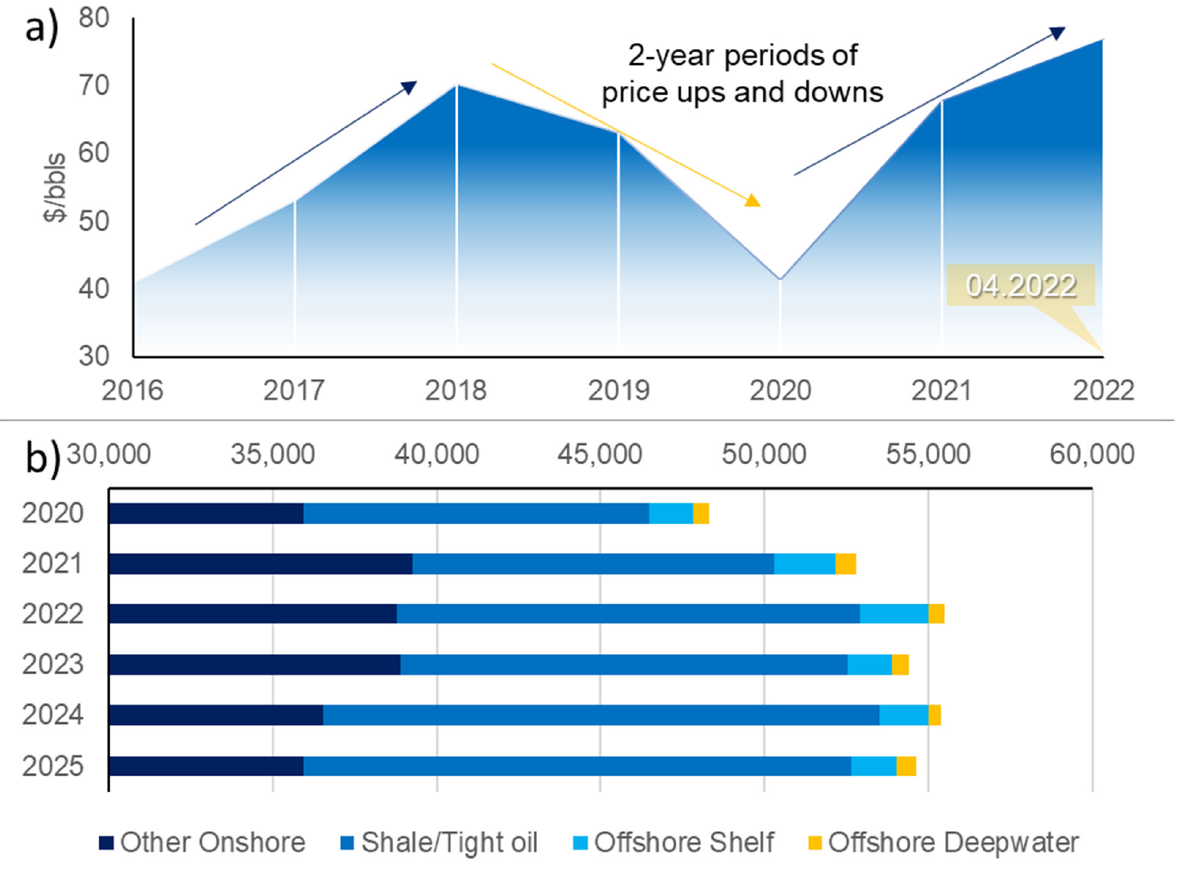
Figure 3. The cost of oil and changes in drilling volumes: ( a ) the cost of Urals oil according to VYGON Consulting; ( b ) global changes in well drilling and completion, pcs. [17,18].